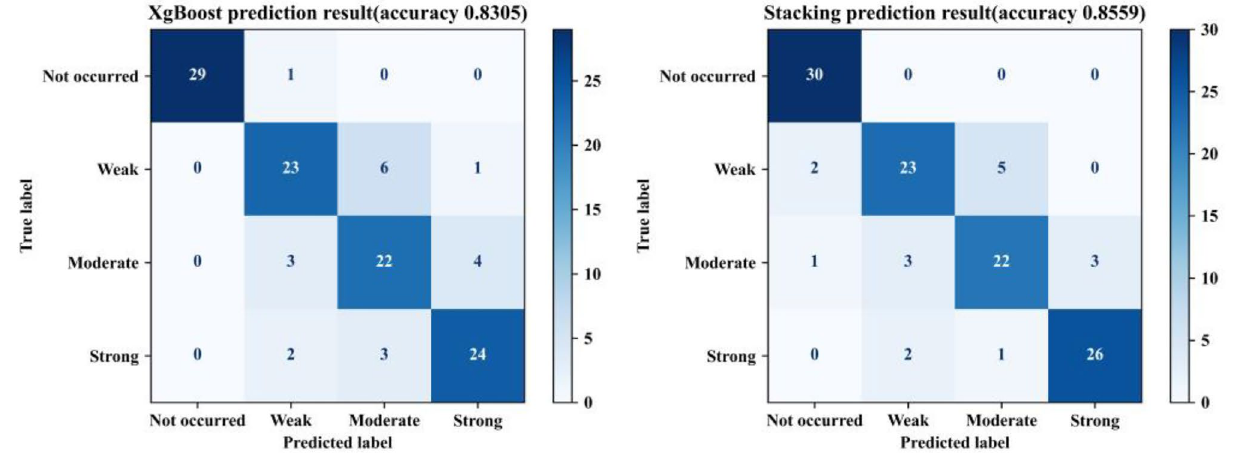
Figure 9. Confusion matrix diagrams for the XgBoost model and stacking